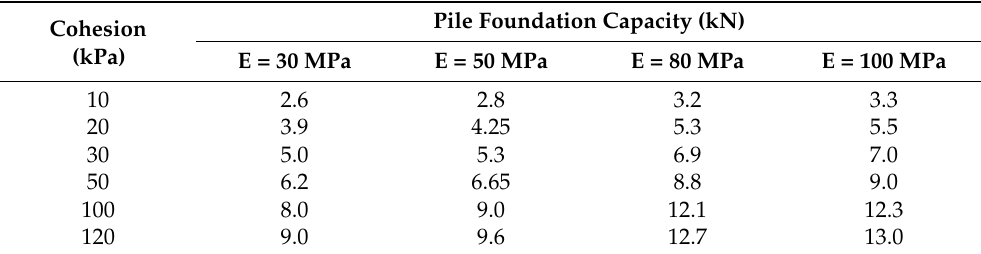
Table 8. Pile foundation capacity in relation to cohesion of soil for CHSB 0